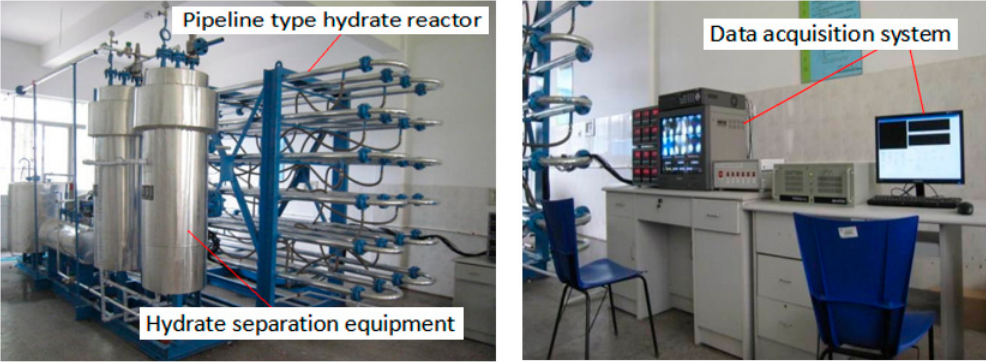
Figure 1. Picture of the hydrate spiral flow loop.